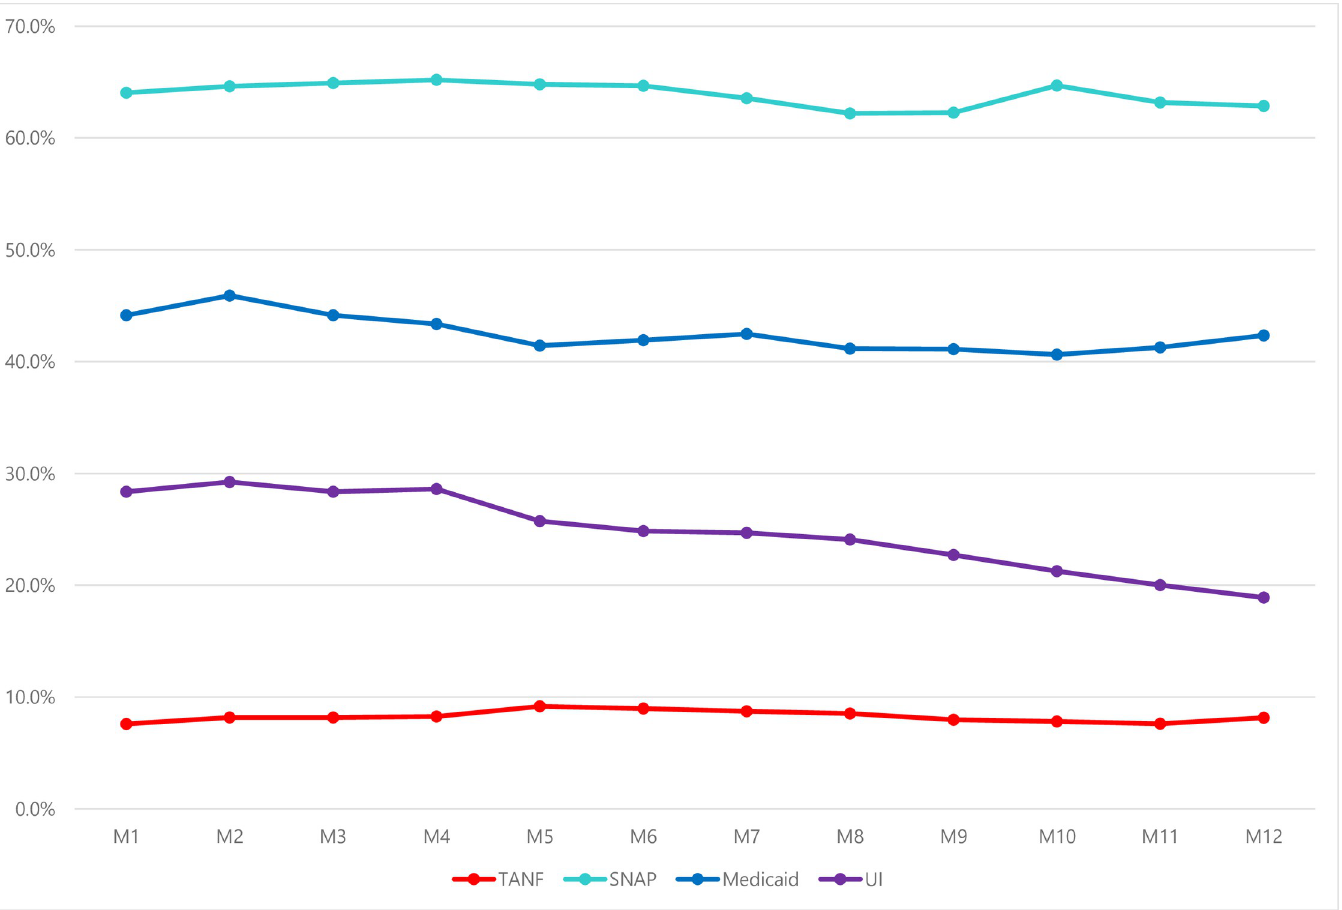
Fig 1. Single program participation rates after first transition from employment to unemployment. Note . SNAP = Supplemental Nutrition Assistance Program; TANF = Temporary Assistance for Needy Families; UI = Unemployment Insurance. M1-M12 represent the months after transitioning from employment to